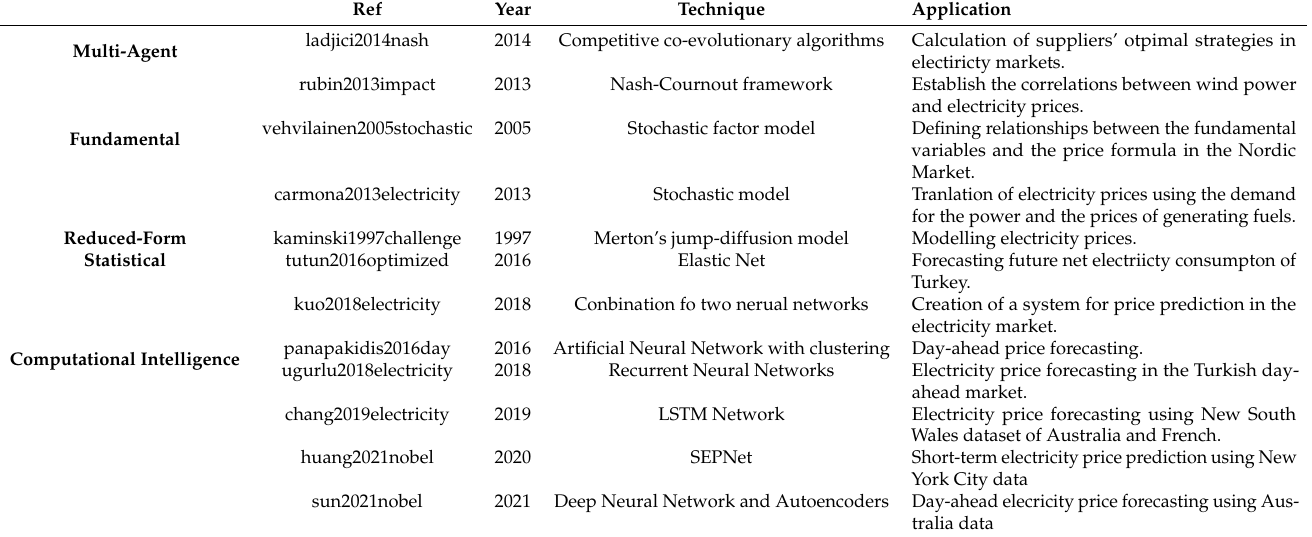
Table 1. Related work on electricity market price forecasting within each of the categories (established by [13]) into which the different models published in the literature so far